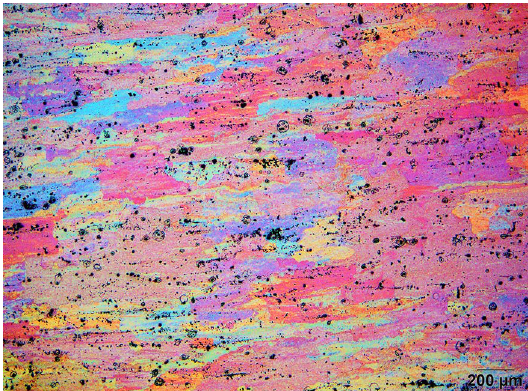
Figure 6. Microstructure of AA 7075 (rolling plane) after cold- rolling obtained by using polarized light microscopy.